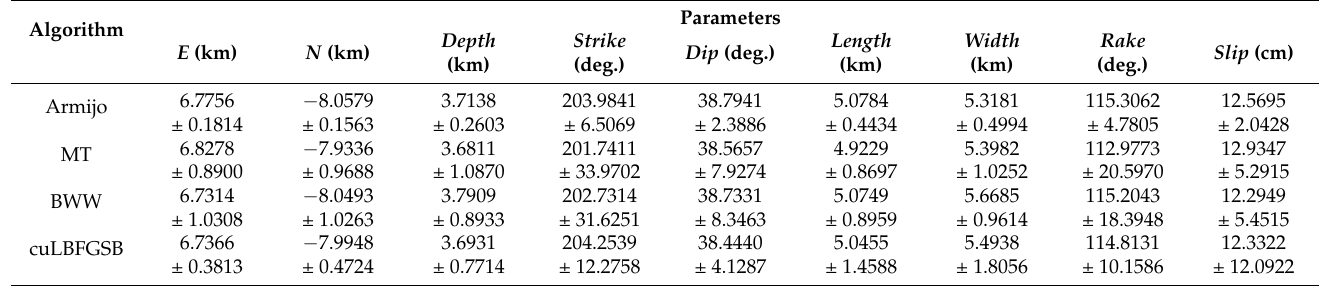
Table 9. The best-fit parameters and a 95% confidence interval of the Monte Carlo